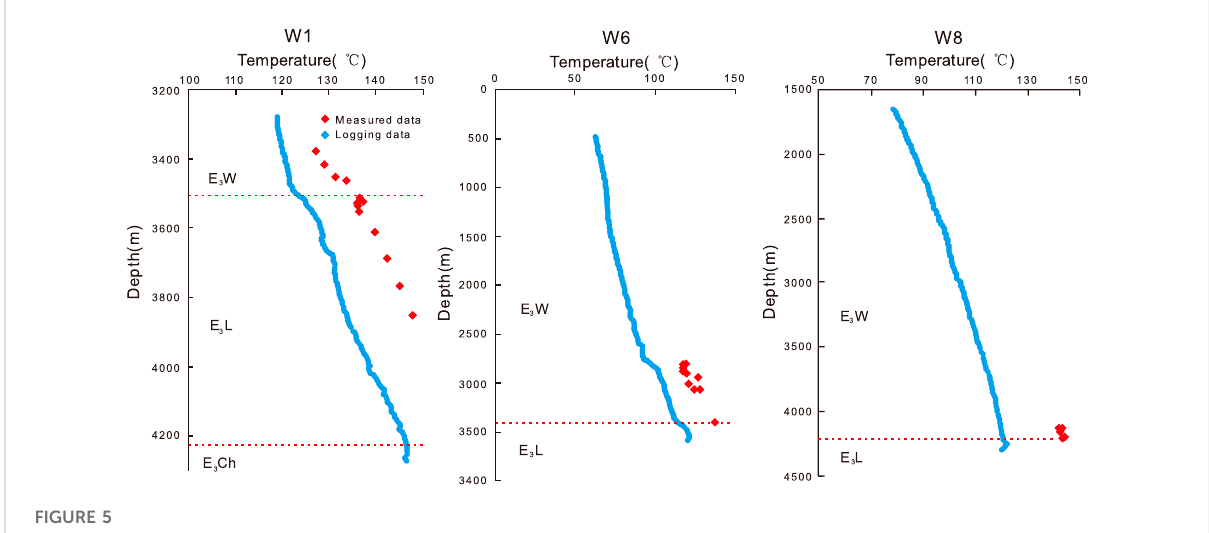
FIGURE 5 Temperature gradient from the measured and logging data.